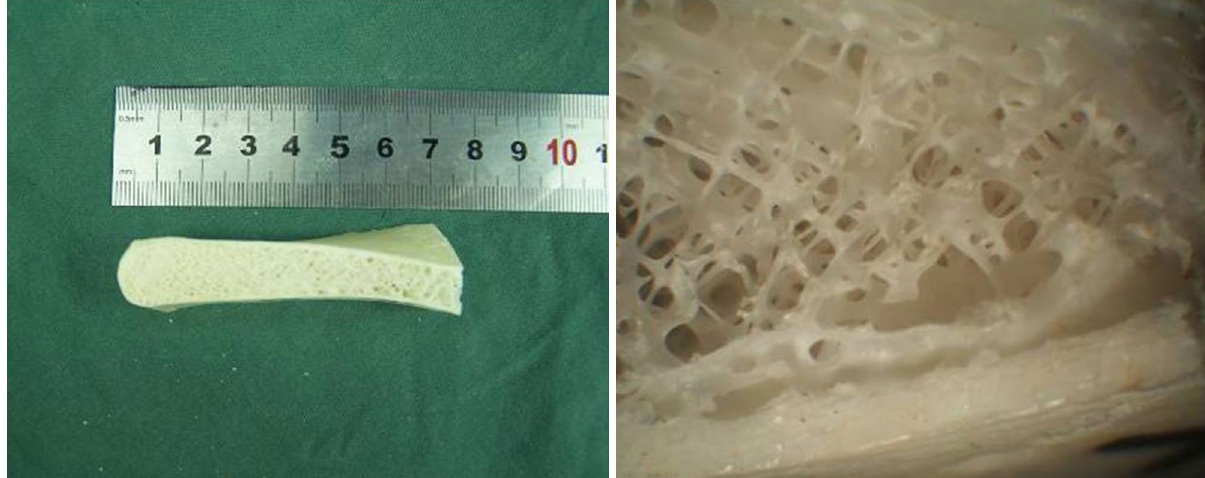
Figure 1. Freeze-dried tricortical iliac crest allograft wedge without bone marrow